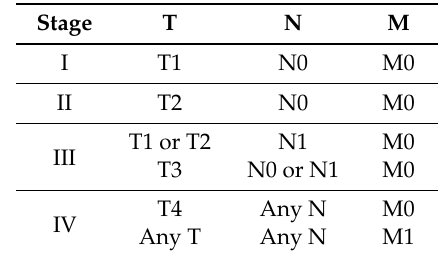
Table 5. Anatomic Stage/Prognostic Groups for Renal Cell Carcinoma. Stage